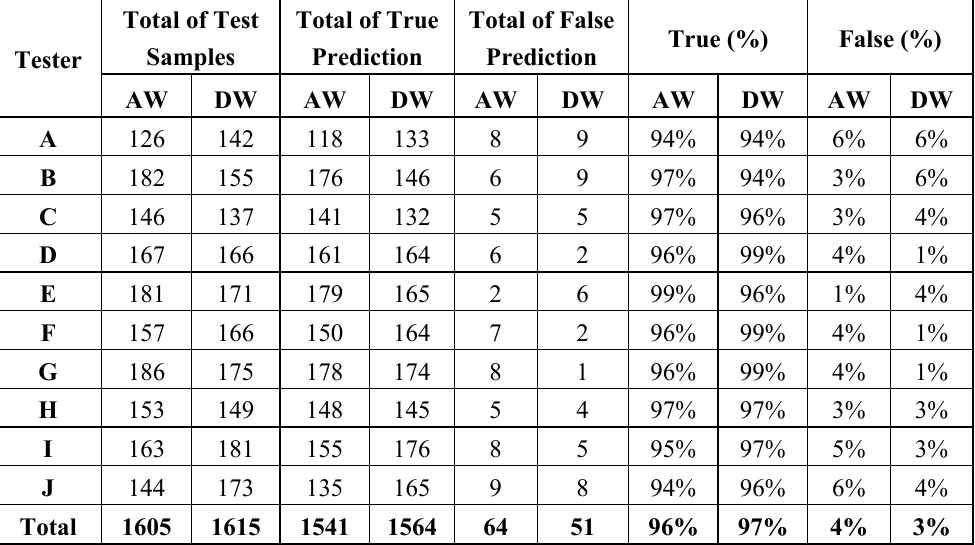
Table 1. FBN inference network performances for ten subjects.